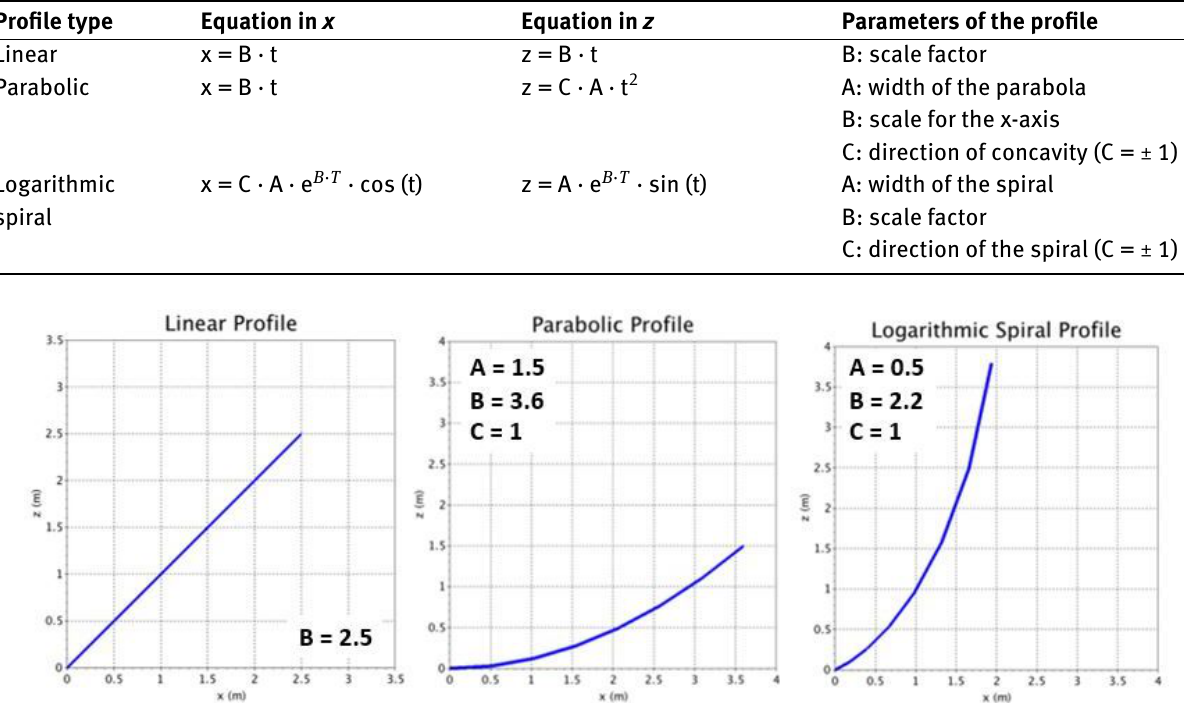
Table 1: Geometric features of the profiles chosen for sound shields